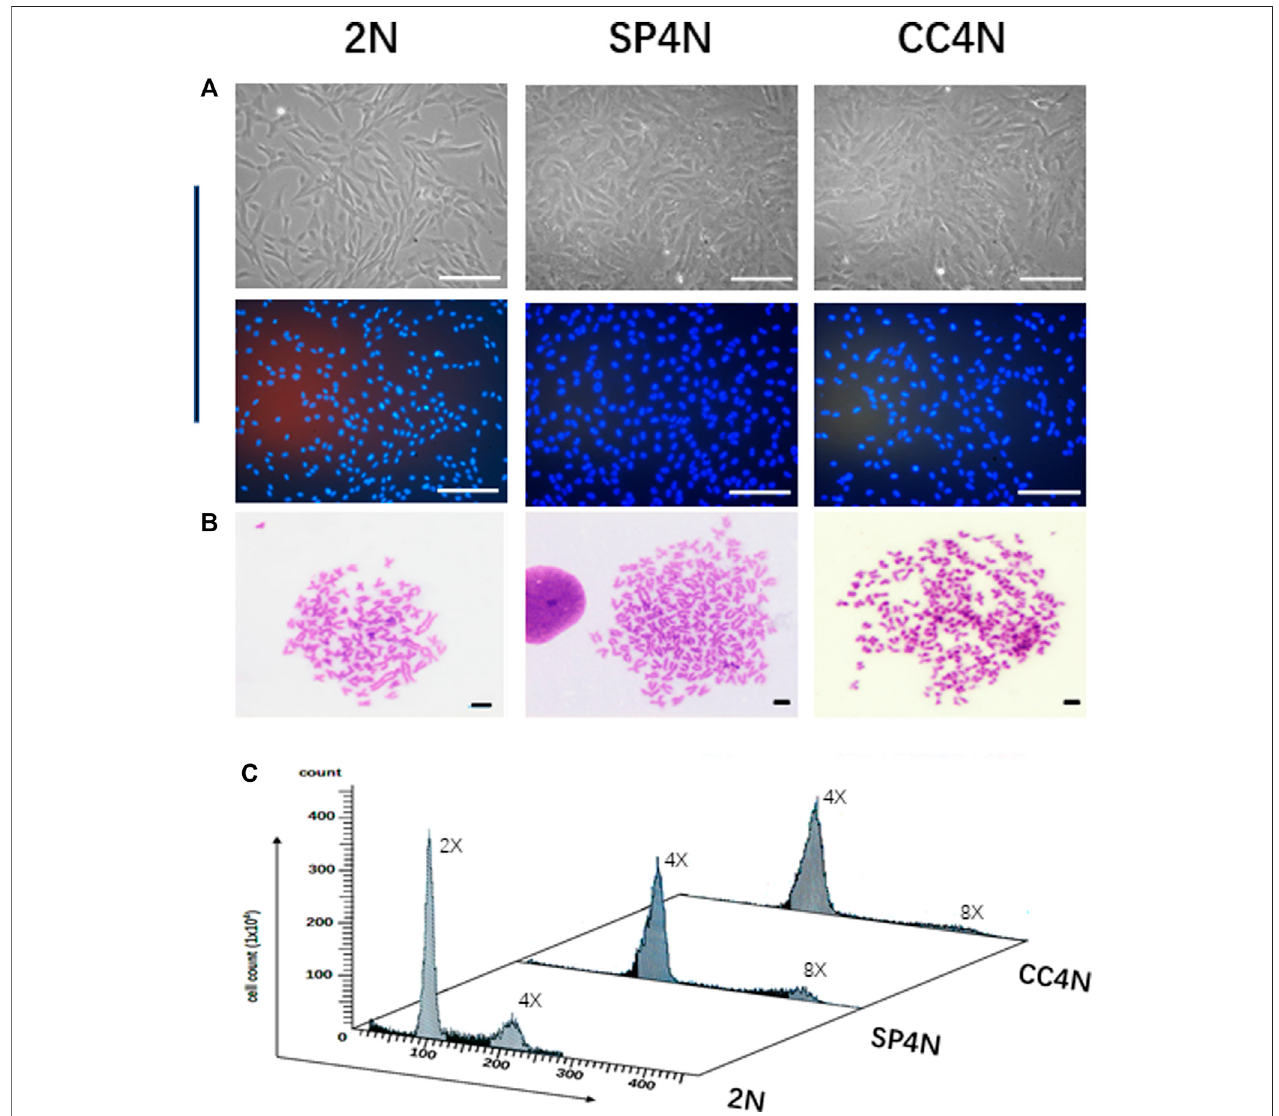
FIGURE1| KaryotypesandDNAploidylevelsoftheSP600125-inducedtetraploidcells(SP4Ncells),tetraploidcellsfrom C.auratus × C.carpioL. (CC4Ncells)and diploid fi sh cells (2N cells). (A) Morphological observation of the 3 cell lines (The cells in the second row were stained with Hoechst 33342), where all the scale bars represent 200 µm. (B) Karyotypes of the 3 cell lines, where all the scale bars represent 20 µm. More than 30 metaphases were examined per-sample. (C) DNA ploidy levelsofthe3 celllineswereanalyzedby fl owcytometry.Foreachsample,experimentswererepeatedatleast3times.Lanesfrom1to3showedtheresultsforthe 2N cells, SP4N cells and CC4N cells,